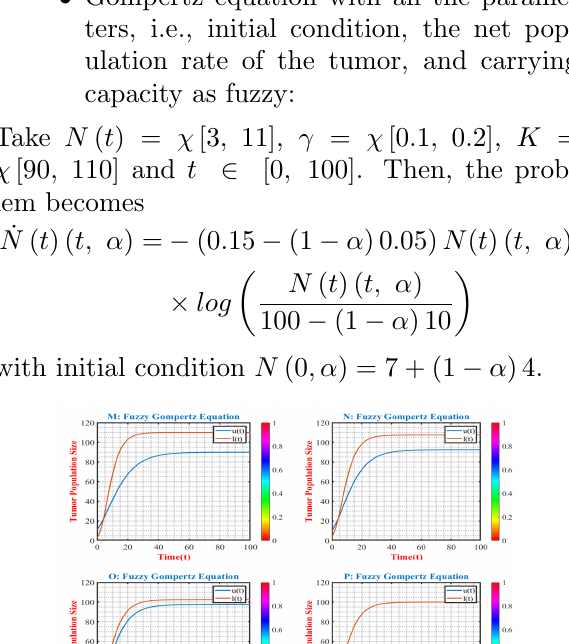
Figure 4. In this case, the system of Gompertz equation with only the coefficient as fuzzy is defined and the tumor population size as a function of time for α = 0, α = 0 . 25, α = 0 . 75 and α = 1 are illustrated.